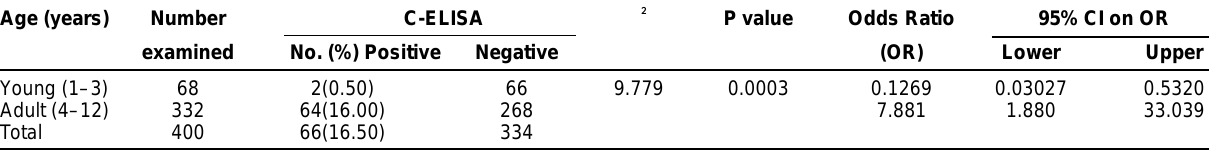
Table-2. Age specific prevalence of Brucella antibodies in camel herds in Yobe state